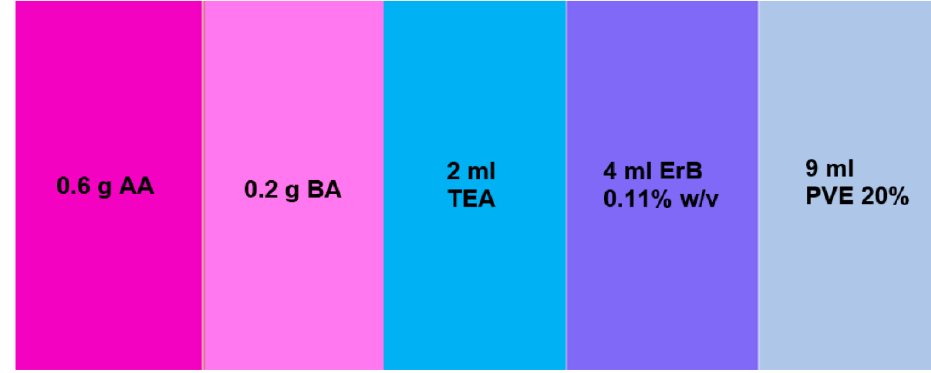
Figure 1. Typical chemical composition of AA-based photopolymer.